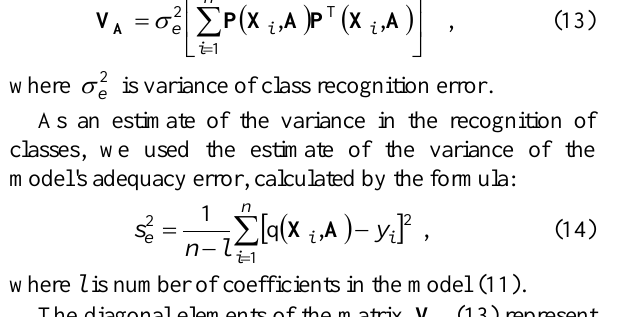
Fig. 3. Approximation of a two-parameter region of admissible values D by an inscribed ellipse DE with a given confidence